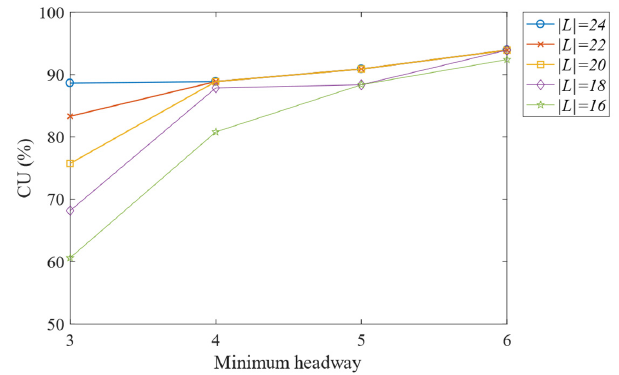
Figure 14. The variation of CU with the increase in the minimum headway.